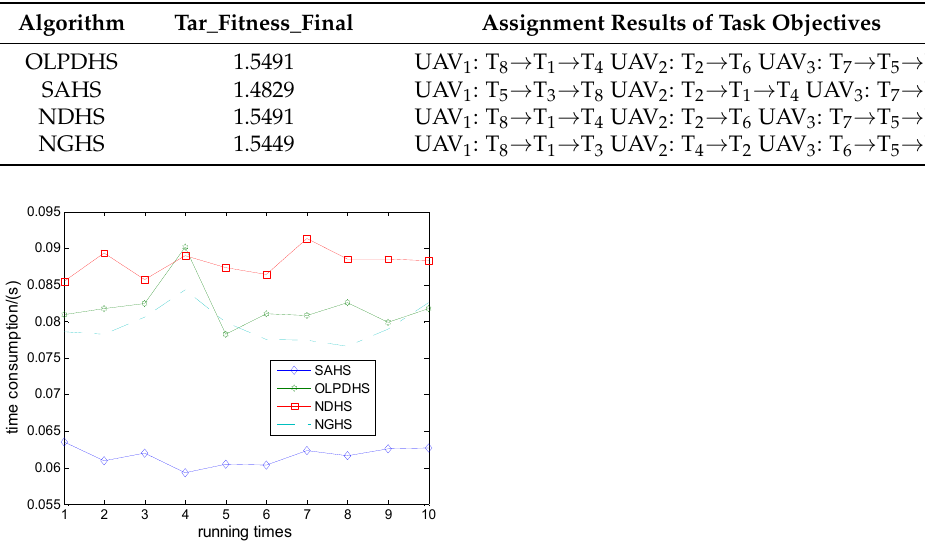
Figure 9. The average times of the four algorithms running independently 10 times.